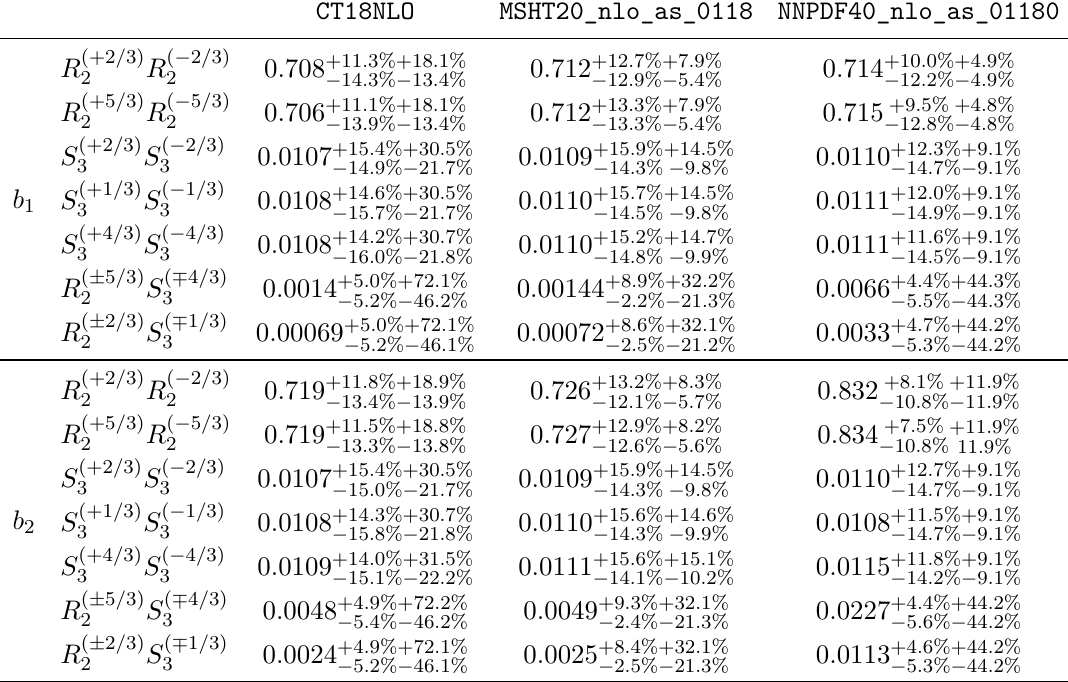
Table 5 . Same as table 4 but for the b 1 and b 2 scenarios of table